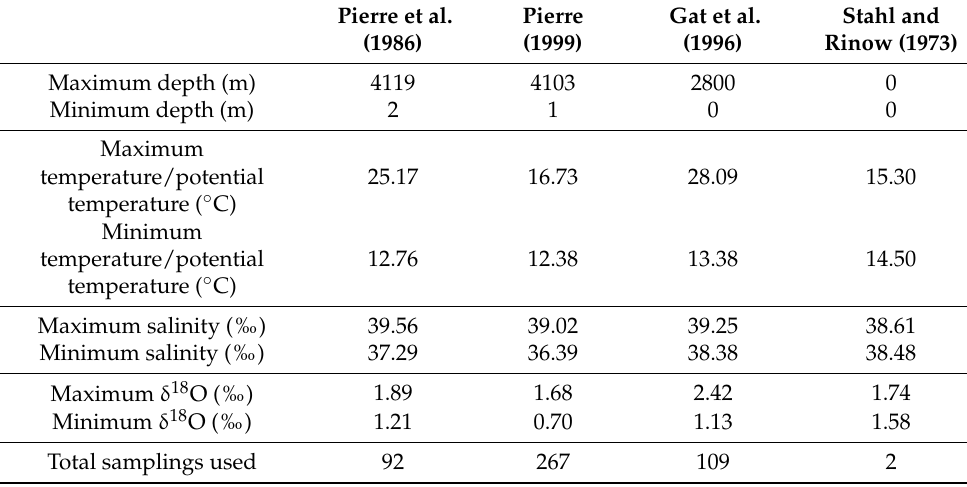
Table 1. Statistics for data used in this